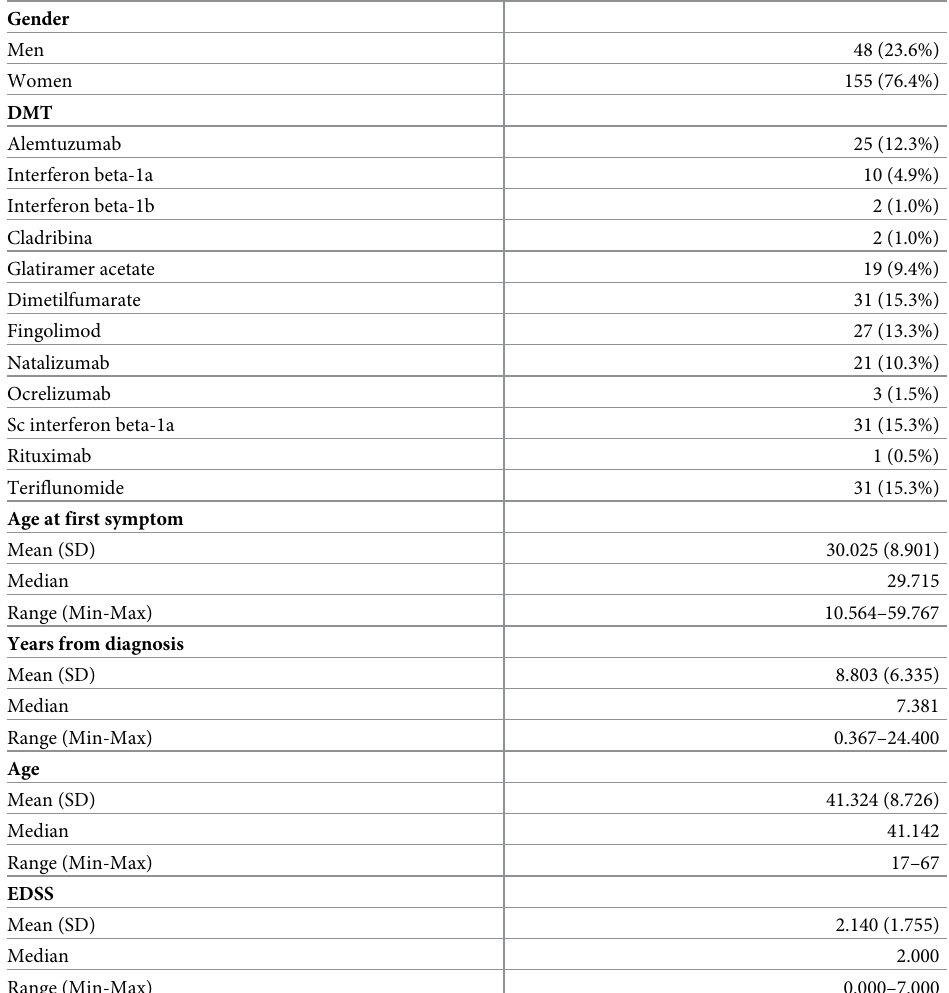
Table 2. Descriptive